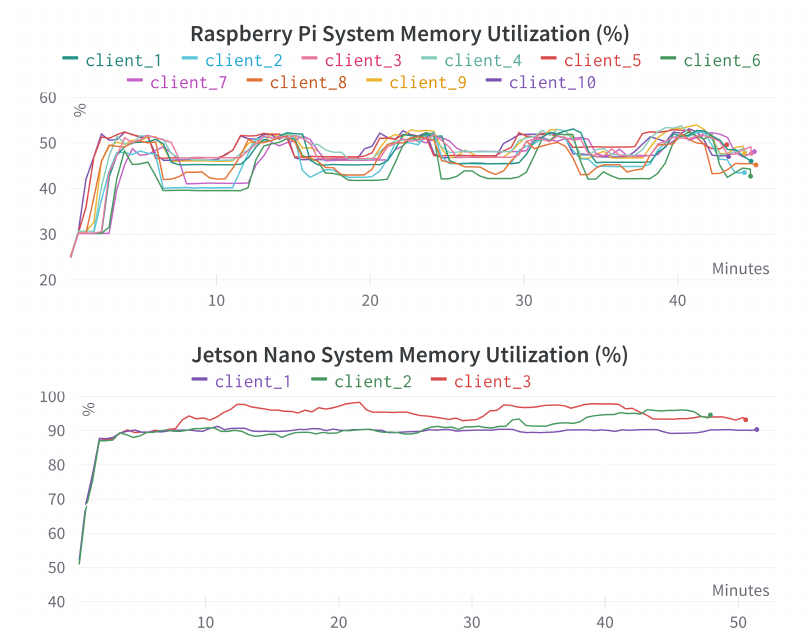
Figure 13. System memory utilization comparison for different Raspberry Pi and Jetson Nano devices. The x-axis represents the time in minutes, the y-axis represents the system memory utilization in percentage